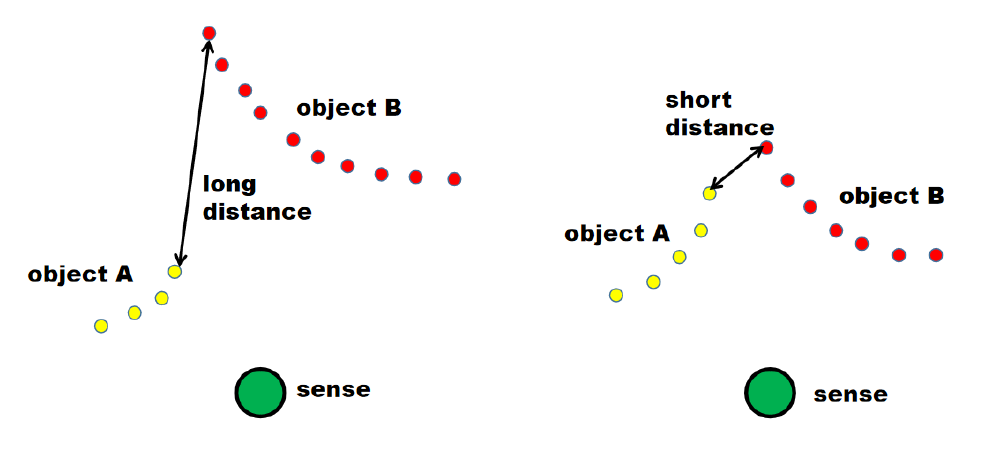
Figure 4. All point clouds in the figure are under the same channel. Yellow represents object A, and red represents object B. The adjacent point clouds of different objects on the left have a long-distance difference, which can be distinguished, but the distance on the right is short and difficult to